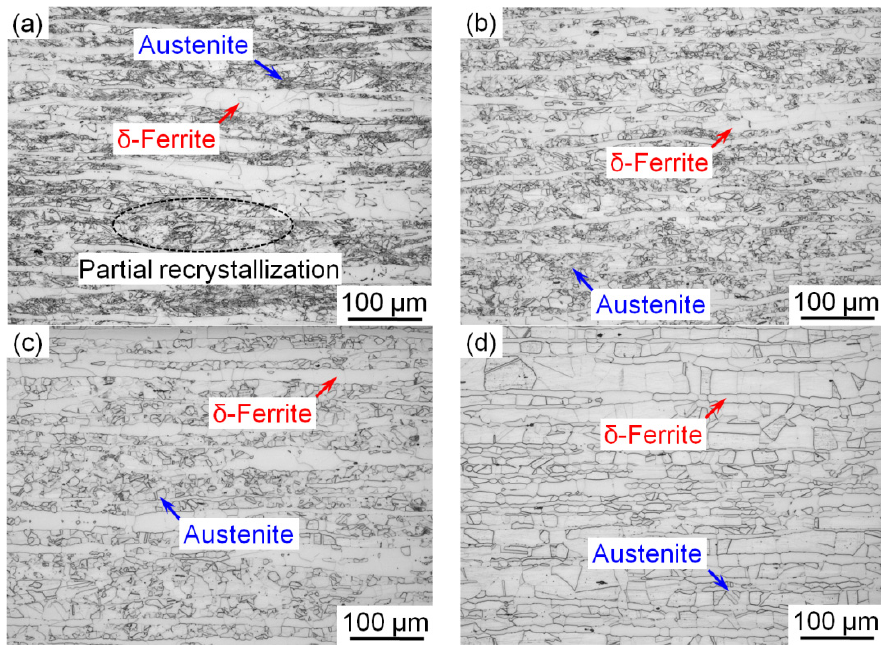
Figure 1. Optical microstructure of the cold-rolled steel annealed at ( a ) 700 °C, ( b ) 800 °C, ( c ) 900 °C and ( d ) 1000 °C for 30 min. Red and blue arrows indicate δ -ferrite and austenite.